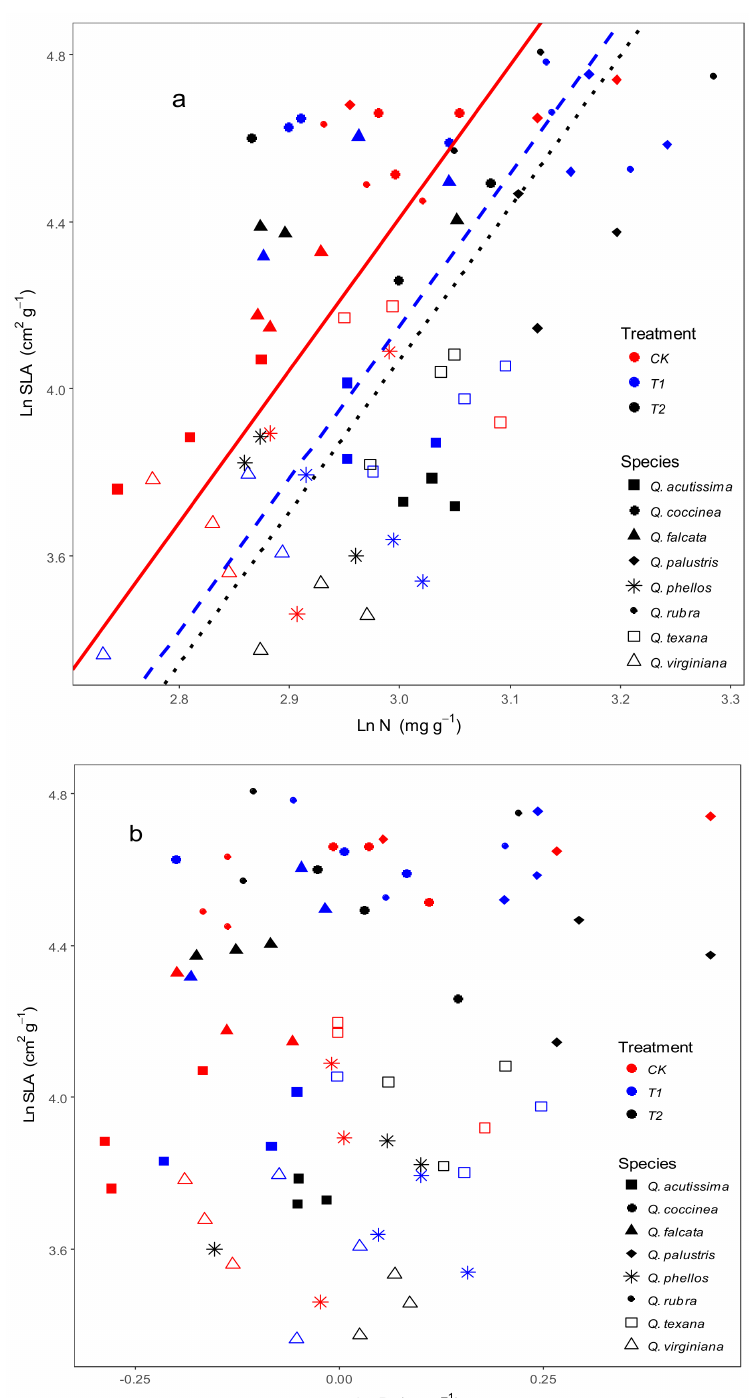
Figure 3. Relationships between leaf N, P concentrations and SLA (Specific leaf area) for Quercus species under wind load. Ln N, Ln P and Ln SLA: leaf N ,P concentrations and SLA were transformed using the natural logarithm prior to analysis. CK : control, T1 : about 4 m s − 1 wind speed, T2 : about 6 m s − 1 wind speed. ( a ) Leaf N concentration and SLA. CK : y = 1.78 x − 0.99, R 2 = 0.17, p = 0.04; T1 : y = 2.06 x − 2.01, R 2 = 0.33, p < 0.01; T2 : y = 1.83 x − 1.41, R 2 = 0.18, p = 0.04. SMAs fitted among treatments did not show significant differences in slope ( p = 0.96), but apparent in intercept ( p < 0.01); ( b ) Leaf P concentration and